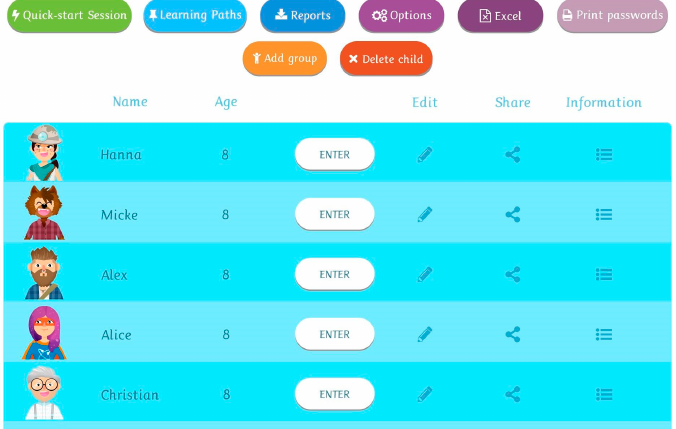
Figure 2. Screenshot of the platform showing management resources for a group of children. Multiple options are given, as seeing the progress and usage time per activity, personalizing profiles, organizing the activities that must be done, adding passwords, and so forth.